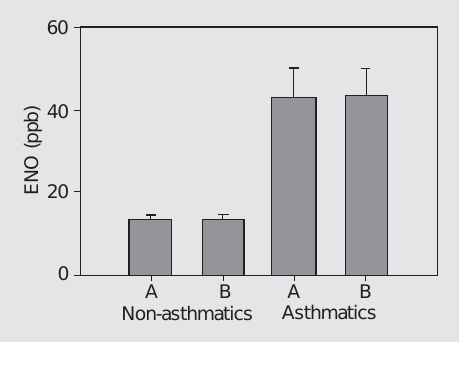
Figure 3. Correlation curve of exhaled nitric oxide (ppb) ob- tained from non-asthmatic (open circles) (r = 0.508) and asthmatic subjects (filled circles) (r = 0.930). There was a positive correlation between the differ- ent devices for both non-asth- matic and asthmatic subject data.